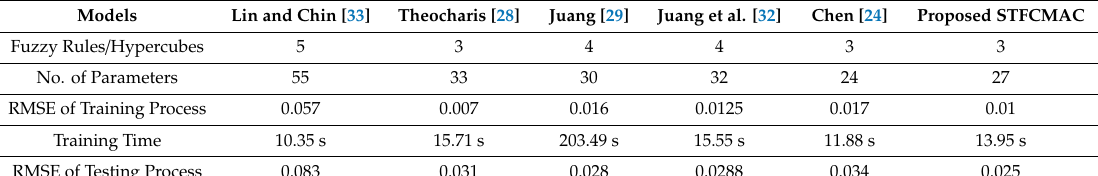
Table 2. A comparison of di ff erent identifiers in terms of the dynamic system identification of longer input delays.